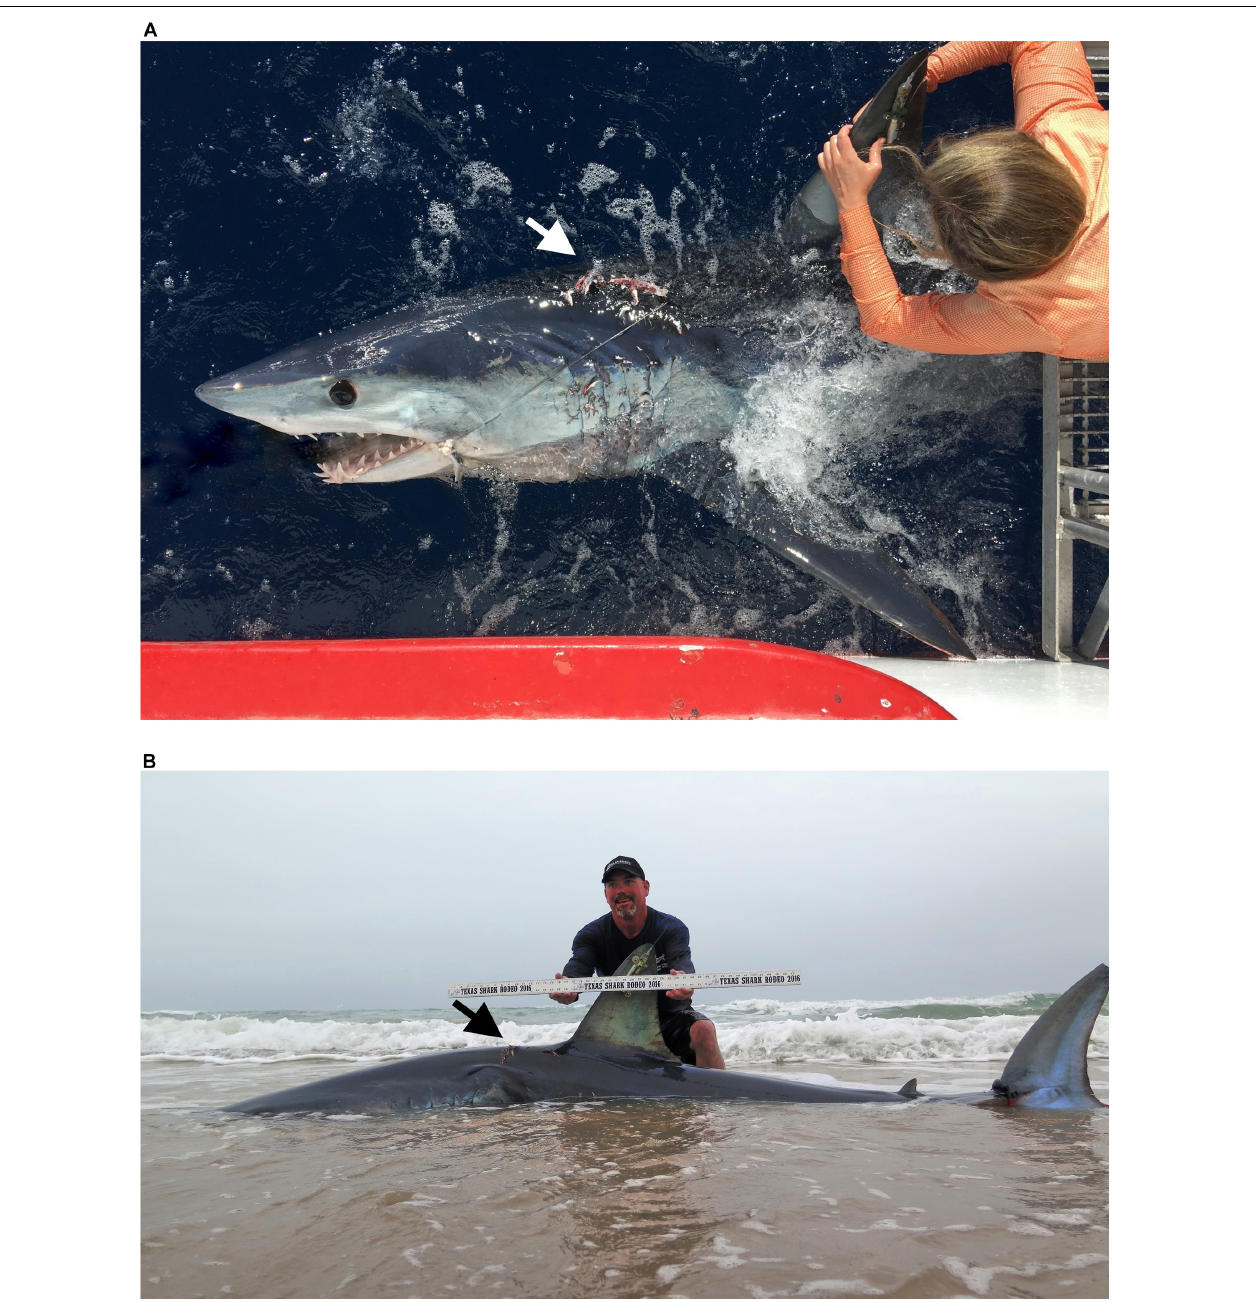
FIGURE 1 | Bite marks (arrows) observed on female shortfin makos, suggesting potential mating or fighting behaviors in the Gulf of Mexico. (A) Shark 6 was tagged offshore in 2017. (B) Shark 1 was tagged in 2016 from Padre Island National Seashore and was recaptured and released 3 h later in the same location.